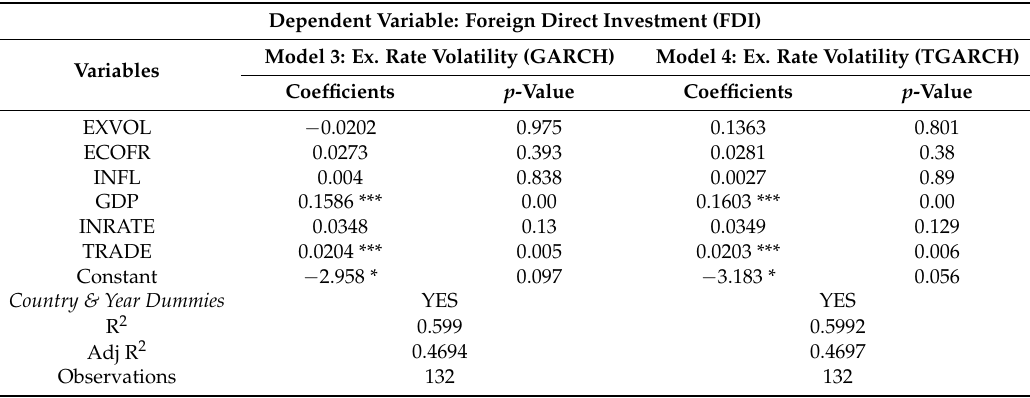
Table A6. FDI and Exchange Rate Volatility: Fixed Effect Model Estimations without the Maldives. Dependent Variable: Foreign Direct Investment (FDI) Model 3: Ex. Rate Volatility (GARCH) Variables